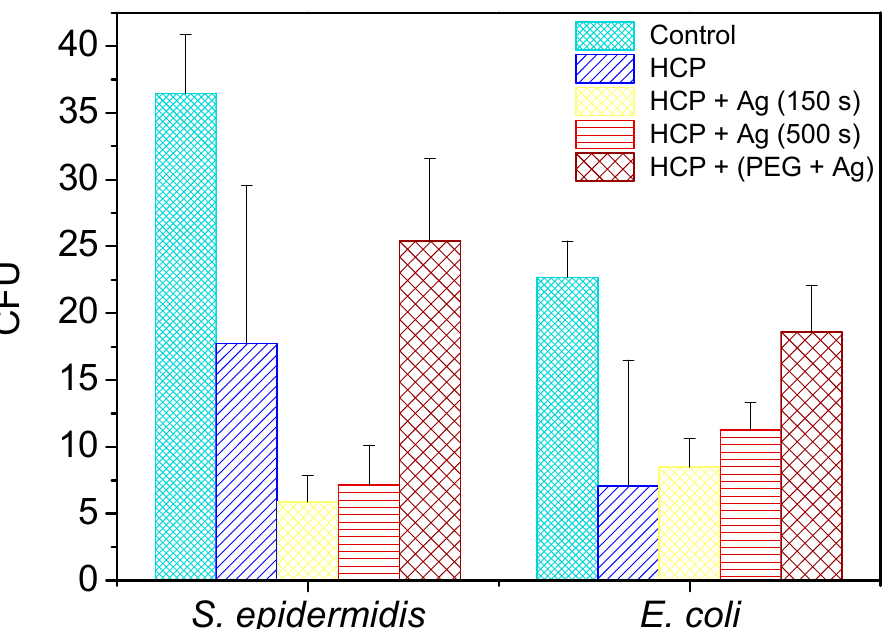
Figure 10. The number of colony-forming units (CFU) of S. epidermidis and E. coli were applied on the surface of the prepared samples of fluorinated ethylene propylene (FEP) for 2 h. The samples were tested after each phase of preparation: (1) A honeycomb-like (HCP) structure formation; (2) sputtering 150 s and 500 s of an Ag layer on the HCP surface; (3) sputtering of Ag into polyethylene glycol (PEG) and embedding the mixture into a solution of HCP structure. Bacterial suspension incubated only with phosphate-buffered saline without any sample addition served as a control. The samples were performed in triplicate [138].